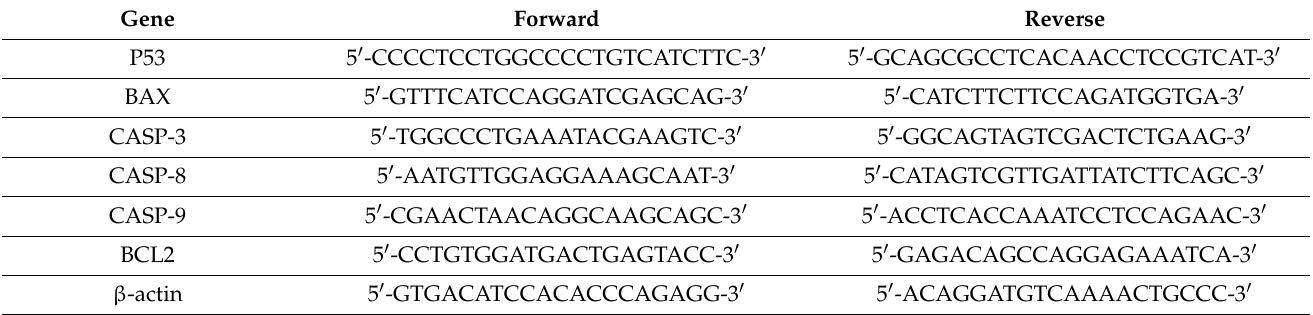
Table 1. List of sequences in forward and reverse of tested